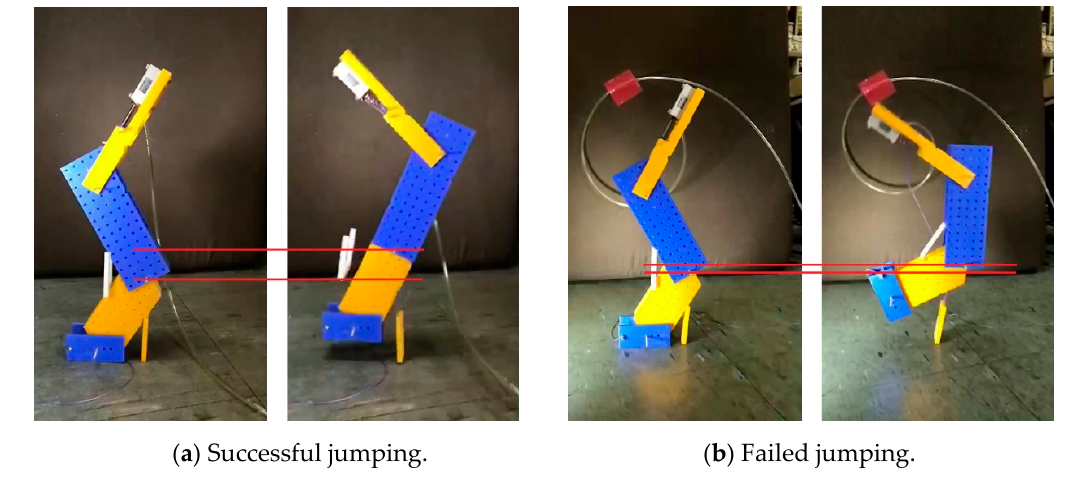
Figure 7. Jumping experiment. ( a ) Successful jumping; ( b ) Failed jumping.